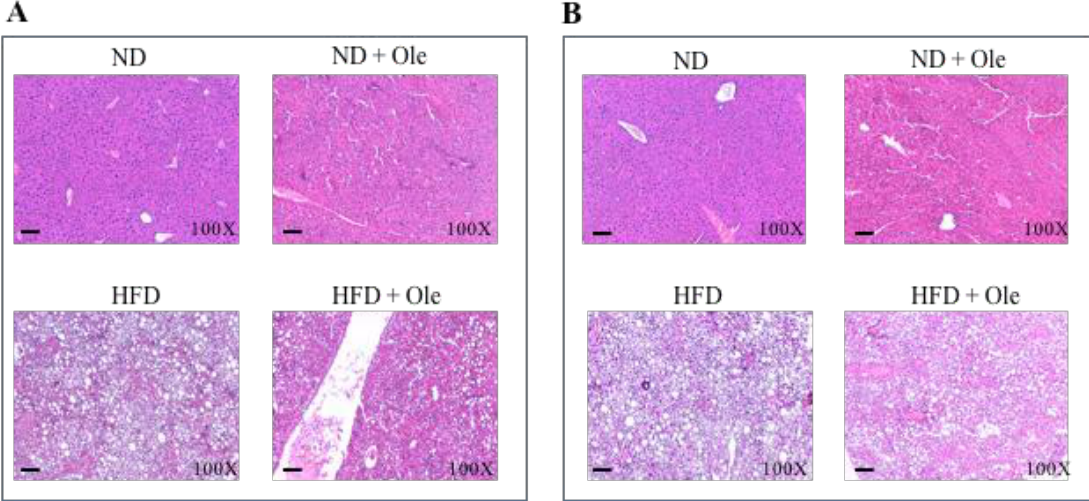
Figure 1. Effects of Ole treatment on liver histology in normal diet (ND) or high-fat diet (HFD) mice. Hematoxylin and eosin staining in liver sections from representative liver tissues of female ( A ) and male ( B ) mice fed ND or HFD in presence or absence of Ole. Original magnification × 100, scale bar = 80 μ m.